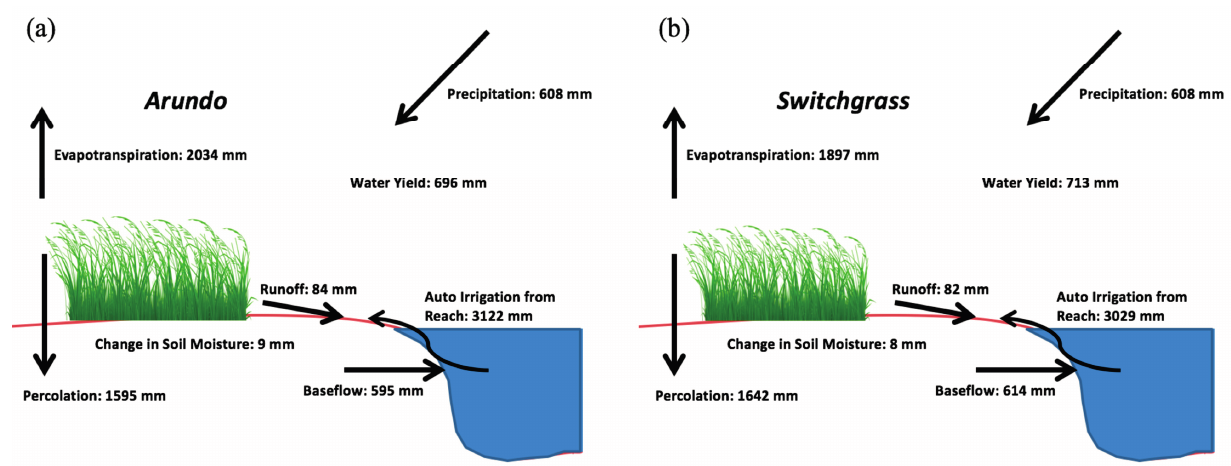
Figure 2. Comparison of water budget for the seven Arundo HRUs under ( a ) Arundo and ( b ) switchgrass scenarios. All the values are annual averages over 16